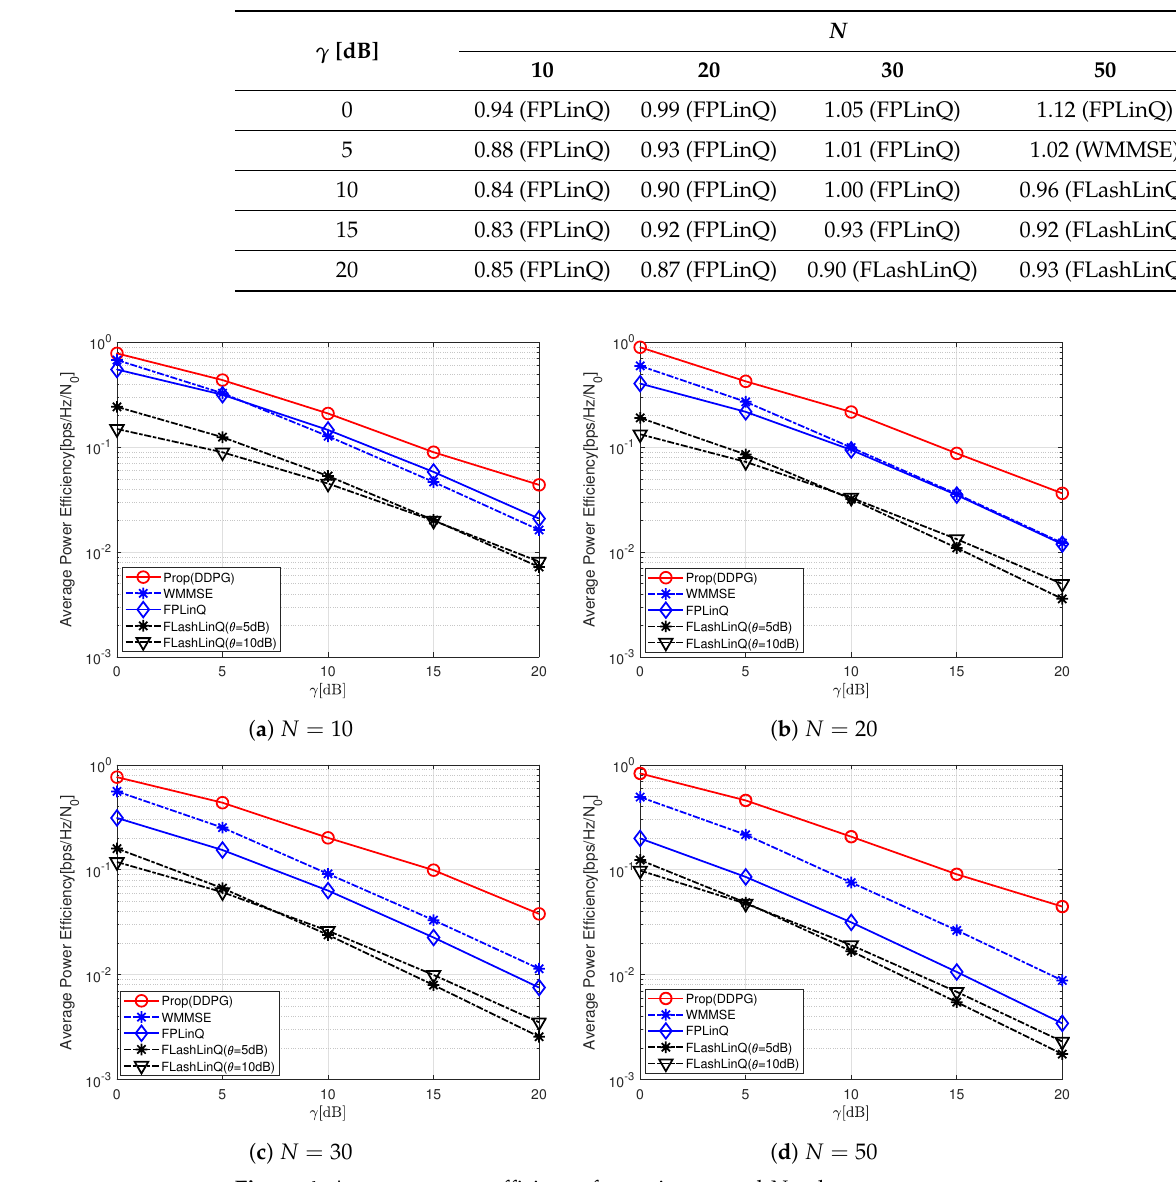
Figure 4. Average energy efficiency for various γ and N